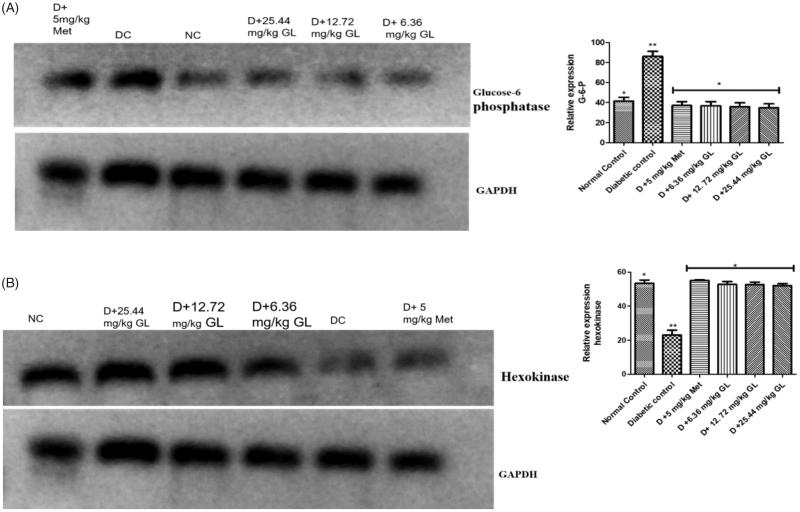
(a) Hepatic hexokinase gene expression in alloxan-induced diabetic rat after administration of aqueous extract of G. latifolium leaf. (b) Hepatic glucose-6-phosphatase gene expression in alloxan-induced diabetic rats after administration of aqueous extract of G. latifolium leaf. Values are expressed as mean ± standard deviation (SD) of eight replicates. Bar with the same * are not significantly different at p > 0.05. Bar with different * are significantly different at p < 0.05. NC or normal control: non-diabetic control; DC: diabetic control; D: diabetic; met: metformin; GL: Gongronema latifolium leaf.